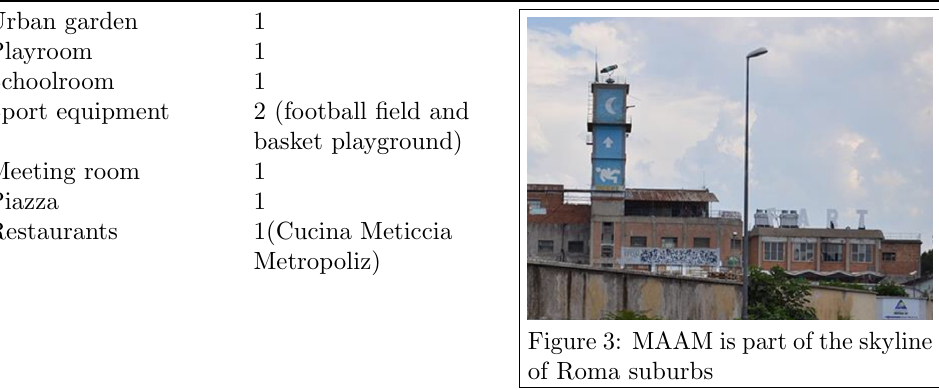
Table 2: Internal relationships of built environment